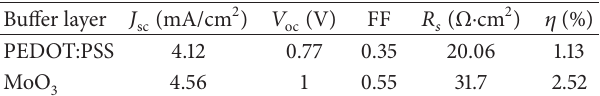
Table 2: Photovoltaic performance parameters of device (ITO/ /SubPc (9 nm)/C (30 nm)/BCP (10nm)/Ag) PEDOT:PSS or MoO 3 60 with different buffer